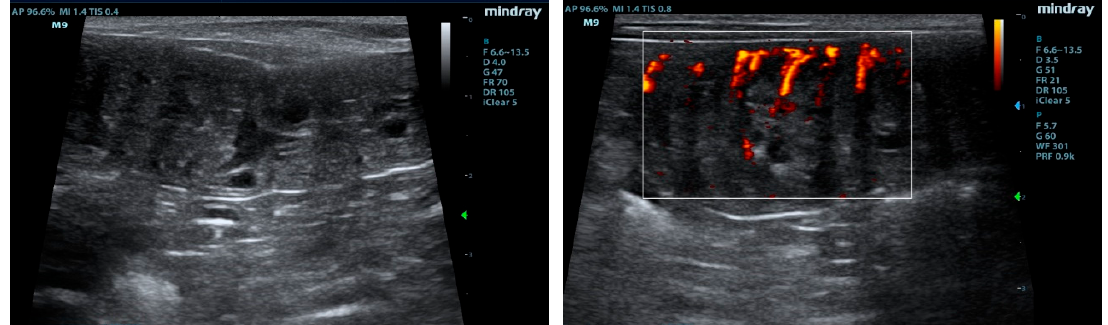
Figure 2. B-mode and color Doppler images of the uterus. Note the ( left ) cavities of cysts and ( right ) endometrial proliferation and vascular signals from the serosa toward the lumen.